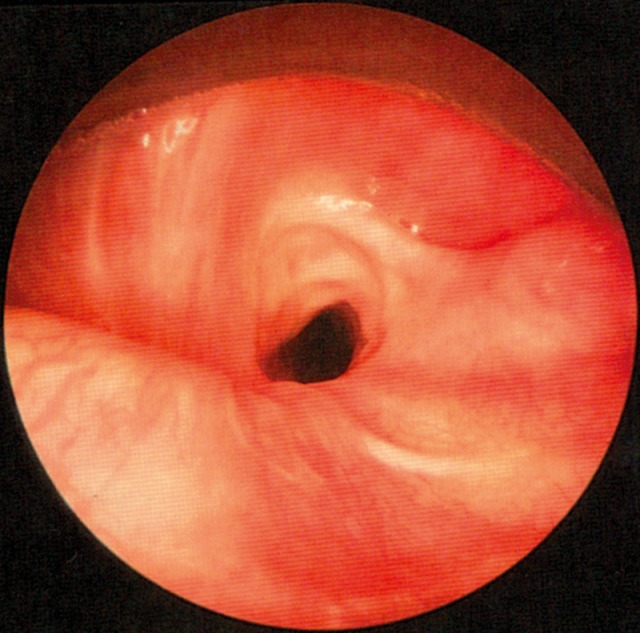
Ring-shaped scar causing stenosis of the distal esophagus